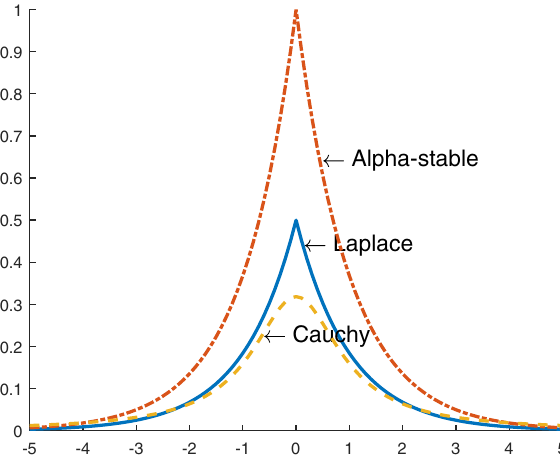
Figure 1. Comparison of the probability density function of heavy tail noise.